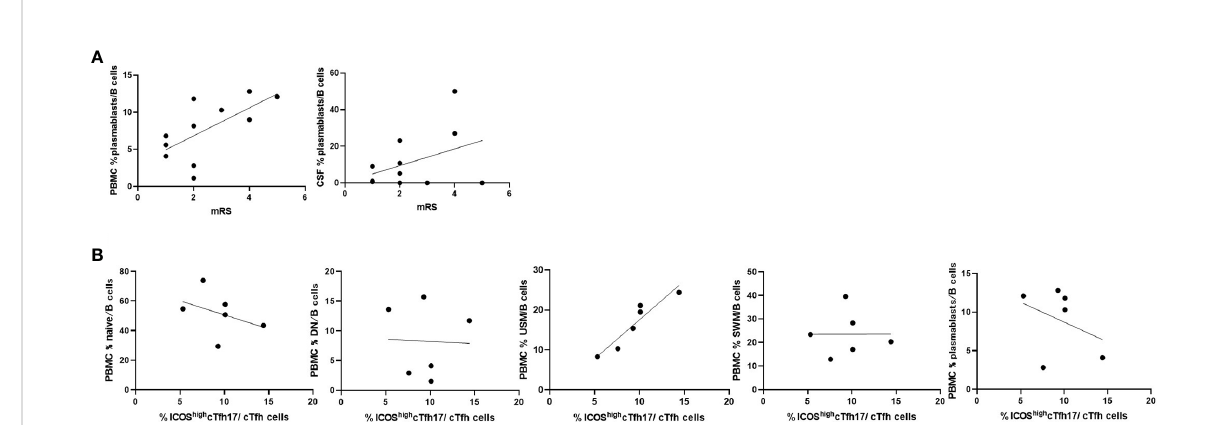
FIGURE 3 Frequencies of B cell subsets were associated with clinical severity and Tfh subsets in patients with AE/Ab(+). (A) Scatter plot of the frequency of plasmablasts within B cells in PBMCs or CSF and mRS on admission of patients with AE/Ab(+) (n = 11). The frequency of plasmablasts within B cells in PBMCs were associated with mRS (Spearman correlation coef fi cient, r = 0.67, p = 0.025). (B) Scatter plot of the frequency of B cell subsets within B cells in PBMCs and the frequency of ICOS high cTfh17 within cTfh cells in PBMCs of patients positive for antibodies against NSA (n = 6). The frequency of USM within B cells in PBMCs were associated with the frequency of ICOS high cTfh17 (Spearman correlation coef fi cient, r = 0.93, p = 0.0059). PBMCs, peripheral blood mononuclear cells; mRS, modi fi ed Rankin scale; cTfh, circulating follicular helper T cell; ICOS, inducible T-cell co-stimulator; naive, naive B cell; DN, double negative B cell; USM, unswitched memory B cell; SWM, switched memory B